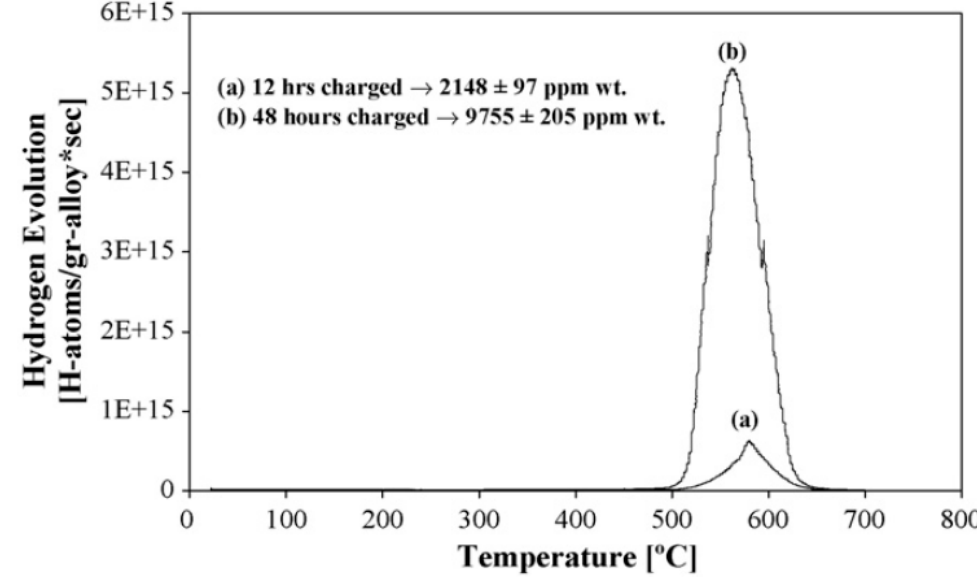
Figure 3. TDS plots of Ti–6Al–4V alloy, hydrogenated for 12 and 48 h, using a constant heating rate of 5 °C/min. Reprinted from [25]. Copyright 2007, with permission from Elsevier.